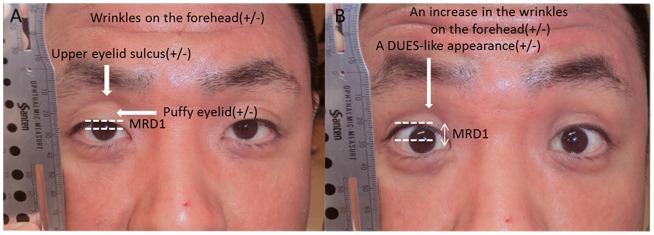
Parameters used in this study. A: Natural open eyes. B: Wide-open eyes.MRD1: margin-to-corneal light reflex distance. A DUES-like appearance: a deepening of the upper eyelid sulcus-like appearance.